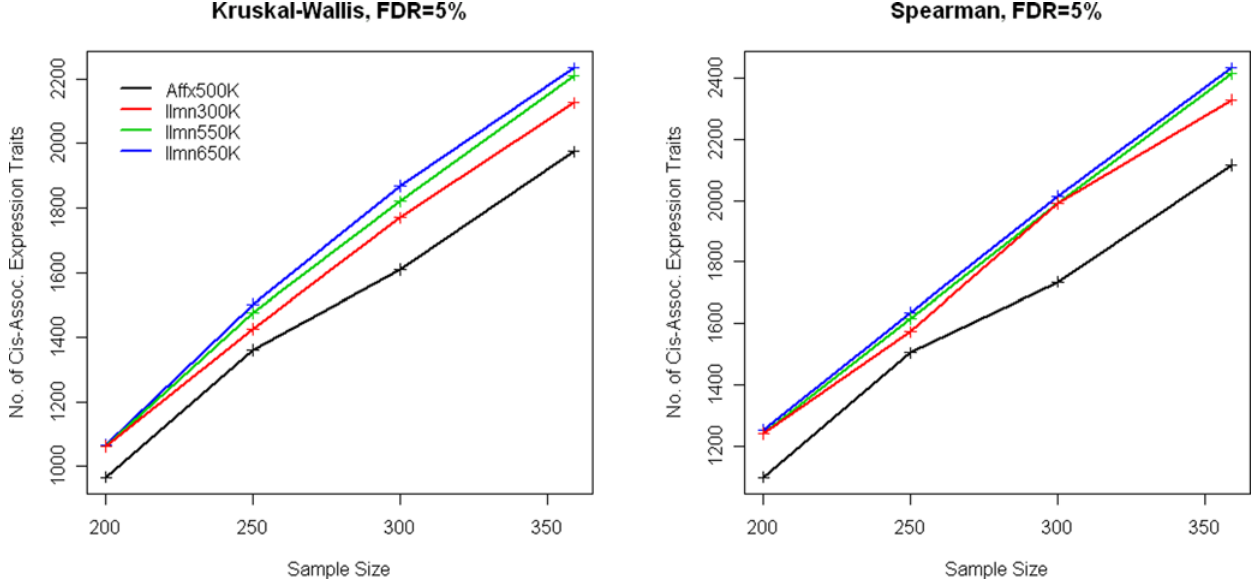
Figure 5. The number of significant cis -associations among the liver gene expression traits at FDR=% at varying sample sizes. The relative number of significant associations is an empirical estimate of the relative levels of power of the different platforms at different sample sizes.